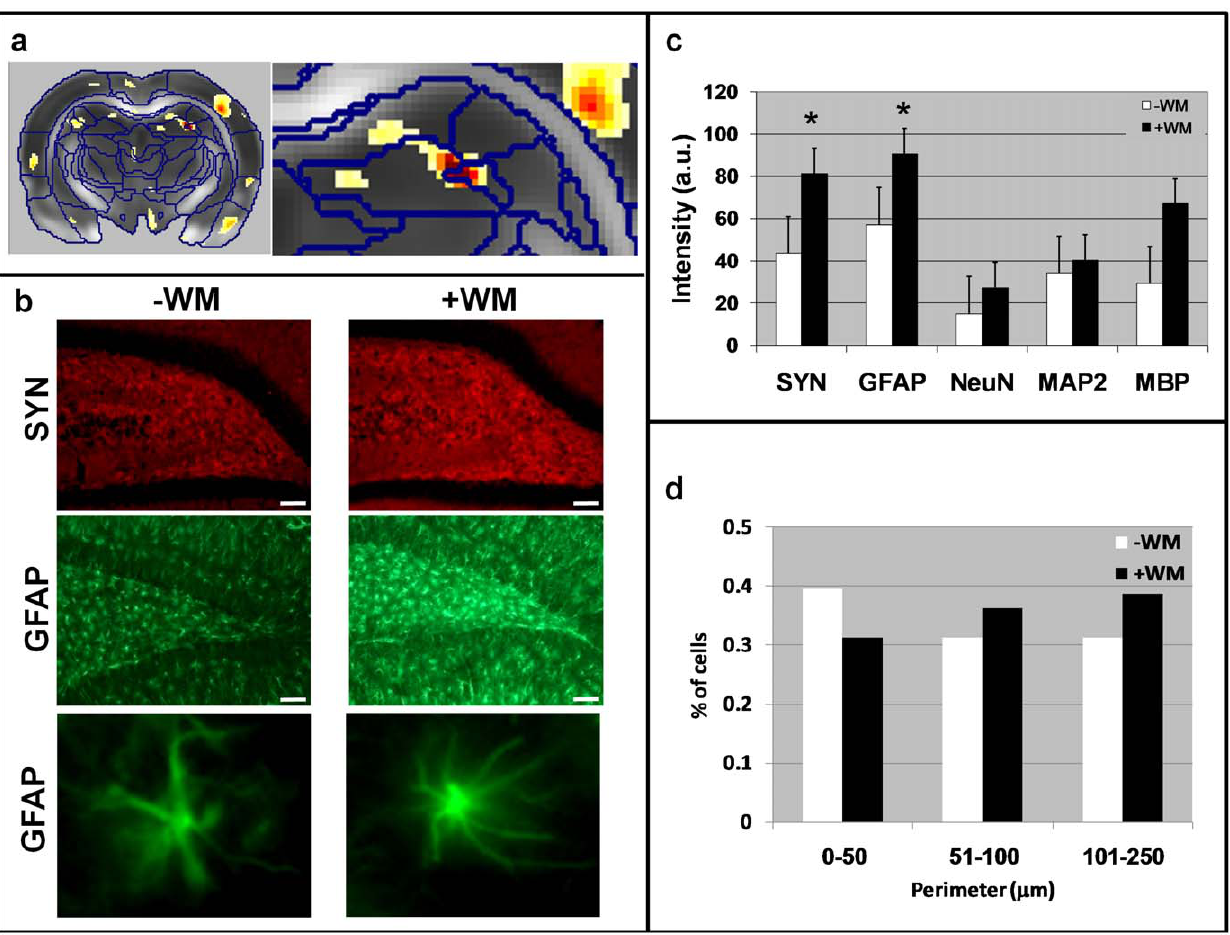
Figure 3. Geometrical and histological analyses of the dentate gyrus and hippocampus in representative mice from group L. ( a ) Statistical parametric map of interaction between scan time and group in a representative slice that includes the hippocampus and dentate gyrus (DG) region. An enlargement of this region is shown on the right. ( b ) Immunohistochemical staining ( 6 10 magnification) of the cell layer of the DG and hippocampal hilus for synaptophysin (SYN, a marker of synapses) in red, and glial fibrillary acidic protein (GFAP, a marker of astrocytes) in green. Note the increase in SYN and GFAP immunoreactivity in the hilus of the DG after completion of the water maze task. GFAP immunoreactivity in the cellular layer of the DG was also increased following the task. The white bar at the bottom right corner represents 100 m m. The bottom panel of ( b ) shows enlargements of two representative astrocytes, demonstrating the massive structural changes that occurred in this cell type in this study group. ( c ) Quantification of the immunoreactivity (staining intensity) in the hilus of the DG for different markers shows significant increases in SYN and GFAP staining. Asterisk (*) denotes P , 0.05. ( d ) Histogrammatic analysis of the perimeters of GFAP-stained cells in the hilus of the hippocampus. After completion of the water maze task there were fewer astrocytes with small perimeters and more astrocytes with large perimeters indicative